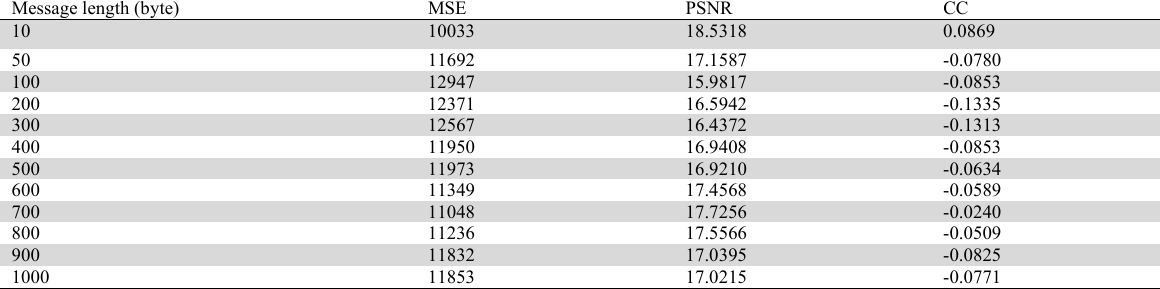
Cryptography for short messages (quality parameters) Message length (byte)